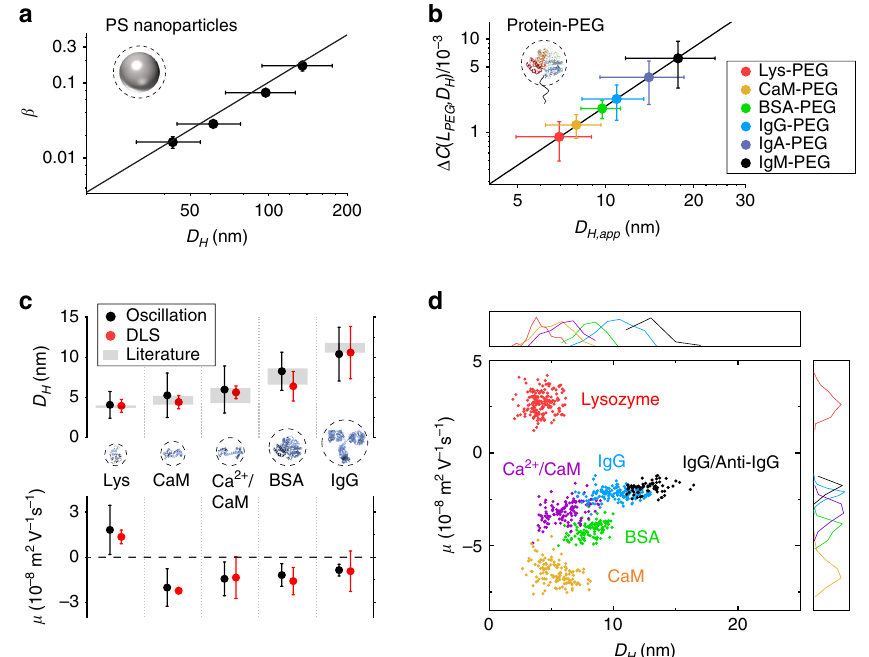
Fig. 4 Identifying proteins based on size and mobility. a Image contrast vs. size for polystyrene (PS) particles. The solid line is fi tting of the data showing a ! 1 ), the image contrast is β according to Eq. (3). power relation of 2.1. Because PS particles bind to the ITO surface from the bulk solution ( Δ z 0 b Determining protein – PEG complex size ( D H,app ) from FFT image contrast change, Δ C ( L PEG , D H ). Unlike PS particles, proteins are tethered to the surface and driven into oscillation with a maximum oscillation amplitude determined by the PEG length. c Comparison of measured D H and µ (Oscillation) with those measured by dynamic light scattering (DLS) experiments performed here and reported in literature. d Mobility ( µ ) − size ( D H ) plot of single proteins and protein – ligand complexes, showing different proteins or complexes are separated in the 2D-plot, which resembles “ 2-D electrophoresis ” . Mobility or size, each alone, cannot clearly separate the different proteins, as shown by the corresponding 1D size and mobility histograms (top and side panels). The error bars for image contrast, size and mobility represent standard deviations of >100 single-nanoparticle or single-protein